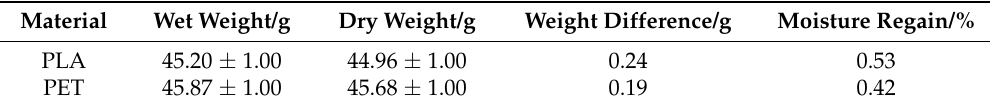
Table 3. Hygroscopic properties of three kinds of multifilament.